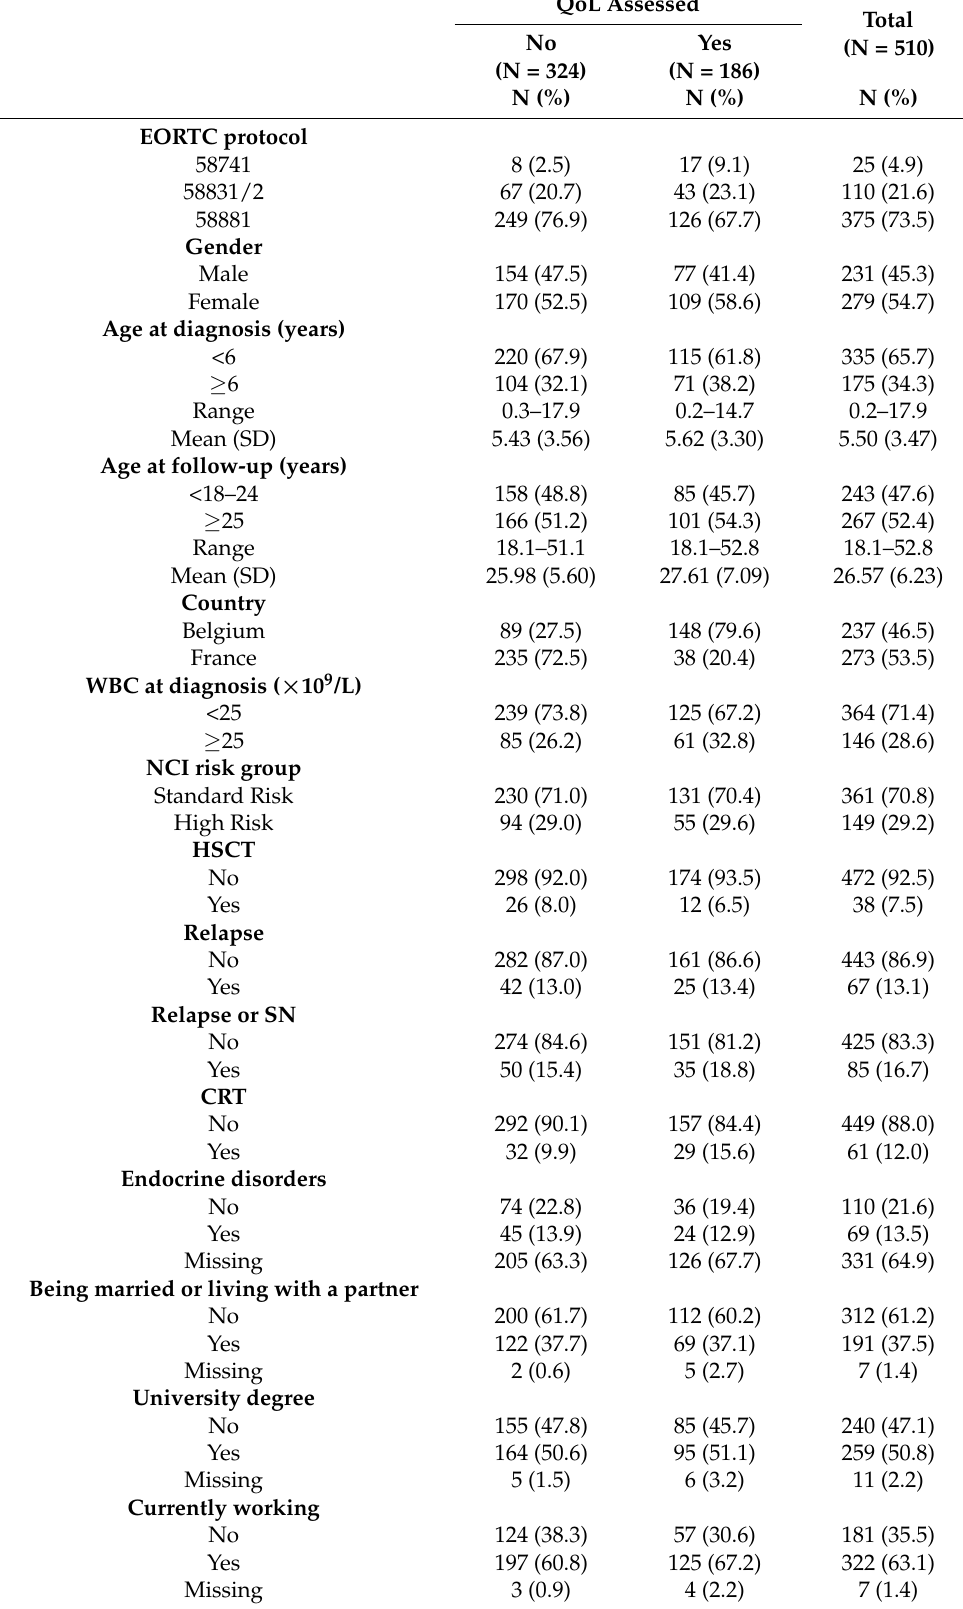
Table 1. Demographic and clinical characteristics of childhood ALL